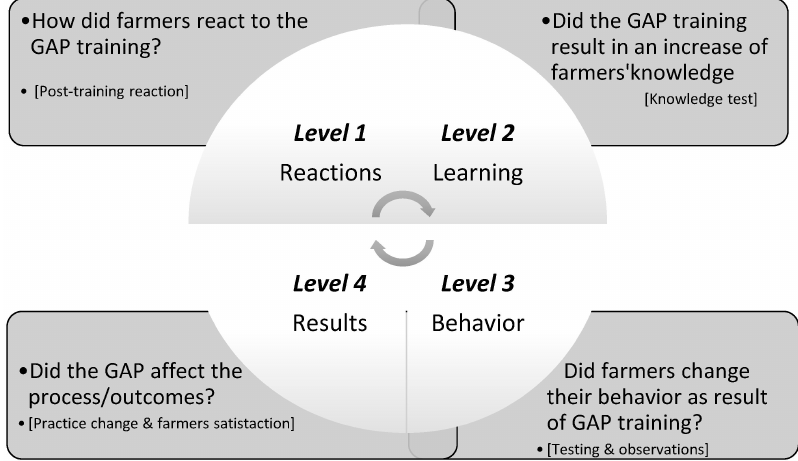
Figure 2. Hierarchical Kirkpatrick